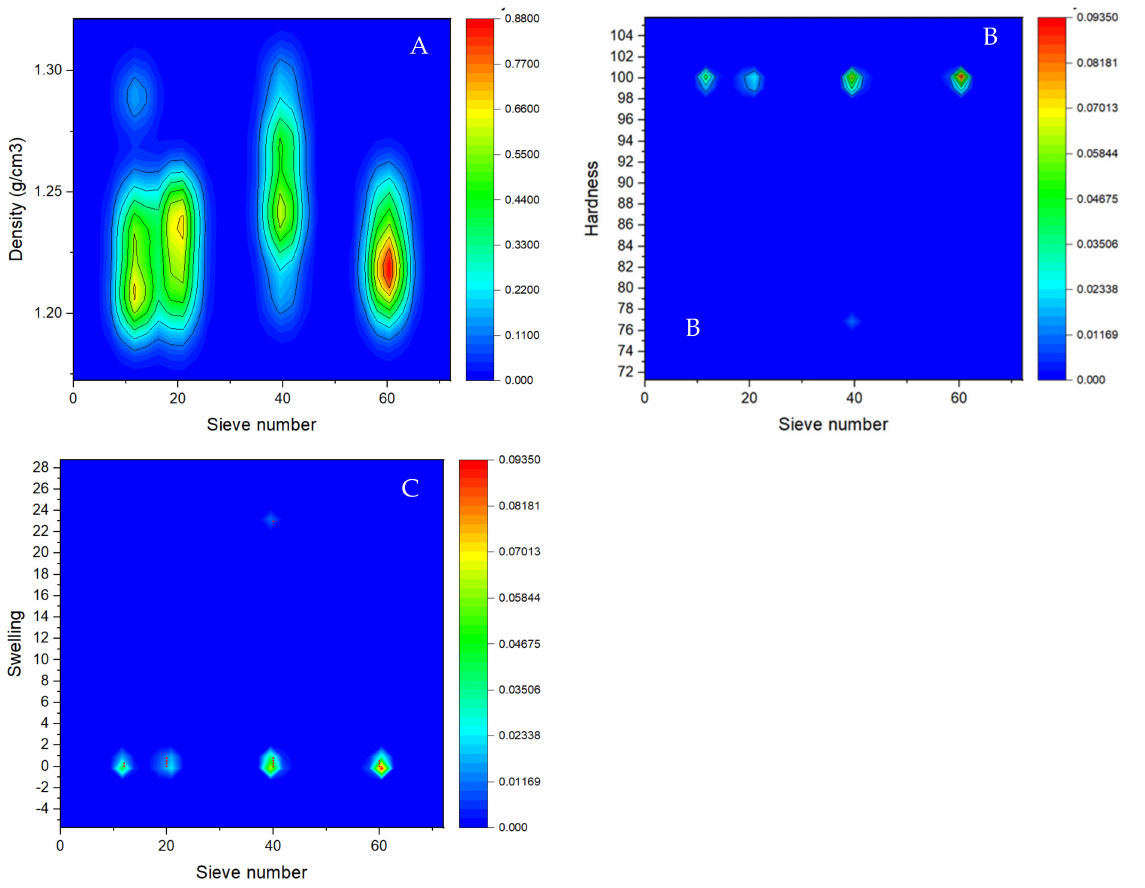
Figure 6. Physical characteristic of biofuel briquettes from pecan pericarp wastes of different particle sizes. ( A ) Density; ( B ) Hardness; ( C )